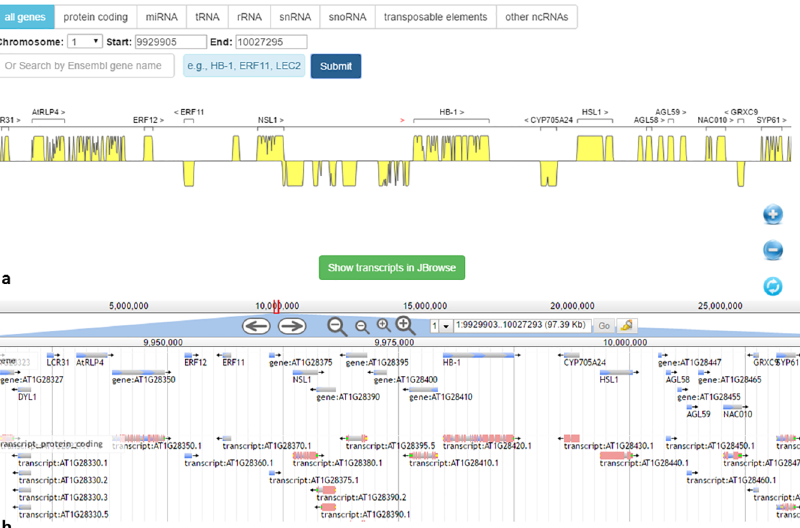
Fig 5. Genome browser views of a randomly selected region in Arabidopsis thaliana genome. (a) BrowserGenome view of the selected region(chromosome: 1; start: 9929905;end: 10027295). (b) JBrowse view of the selectedregion(chromosome: 1; start: 9929903;end: 10027293).